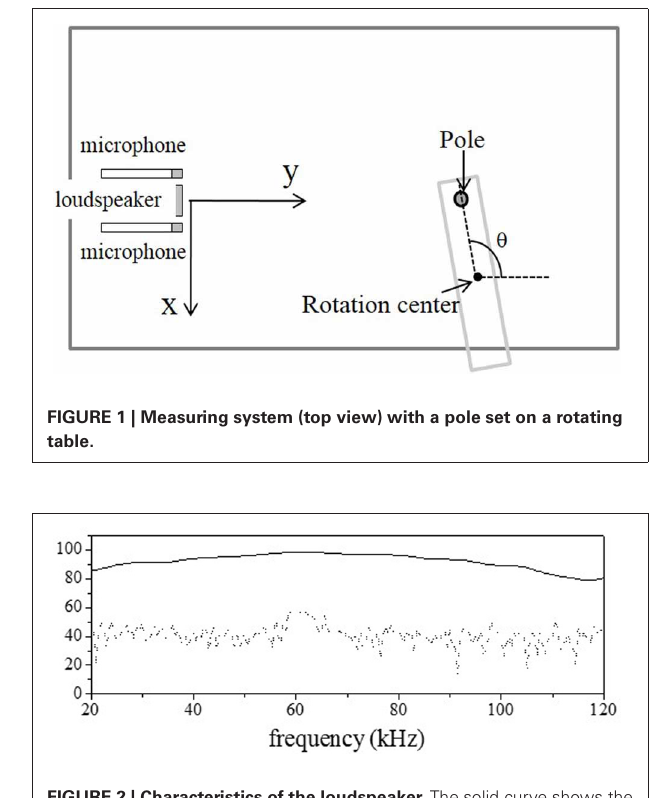
FIGURE 2 | Characteristics of the loudspeaker. The solid curve shows the amplitude spectrum computed from the measured waveform with the loudspeaker facing the microphone. The dotted curve shows the noise